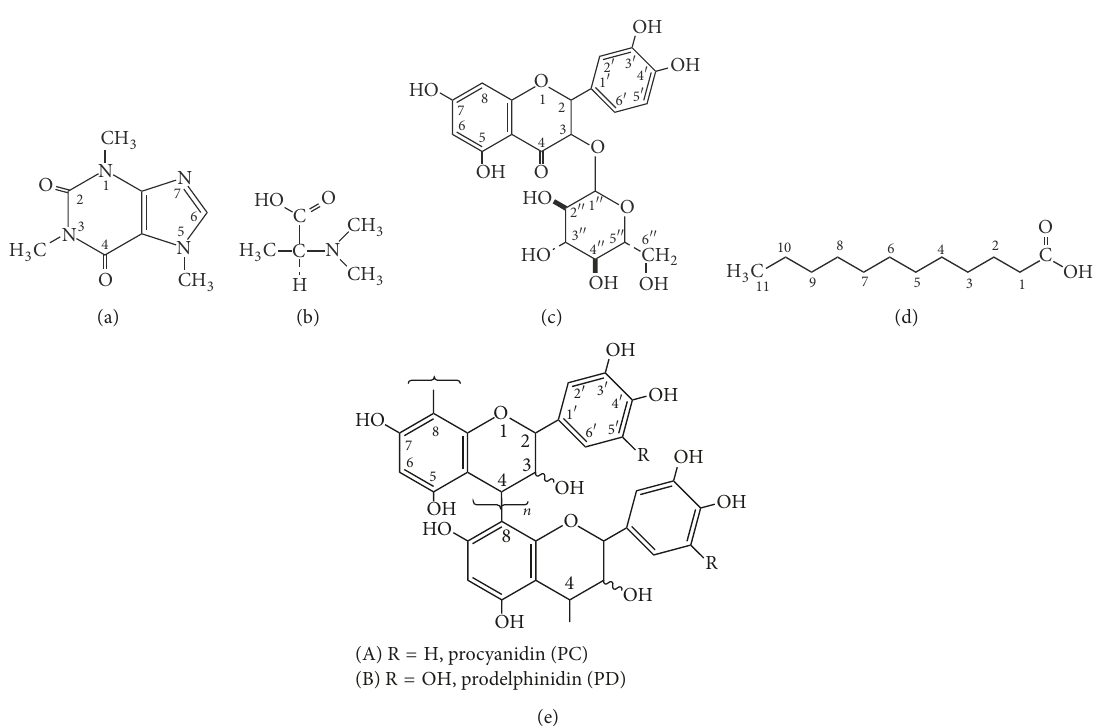
Figure 2: Chemical structures of caffeine (a), N,N-dimethyl-L-alanine (b), quercetin-3-O-galactopyranoside (c), dodecanoic acid (d), and condensed tannins (e).